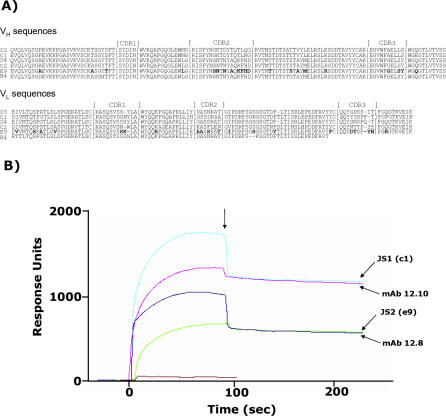
Sequencing of V Genes and SPR Analysis(A) Amino acid sequences of MSP119-binding scFvs. Sequences of six selected scFvs obtained by panning phage display libraries with recombinant MSP119 (C1) or P. falciparum merozoites in which secondary processing had been allowed to proceed (E9). Amino acids in bold represent residues in the E9 sequence differing to C1.(B) SPR association and dissociation curves of Ab binding to MSP119 immobilized on a CM5 sensor chip. Abs were injected into flow at time 0 and replaced with buffer at the point indicated by vertical arrow [24].